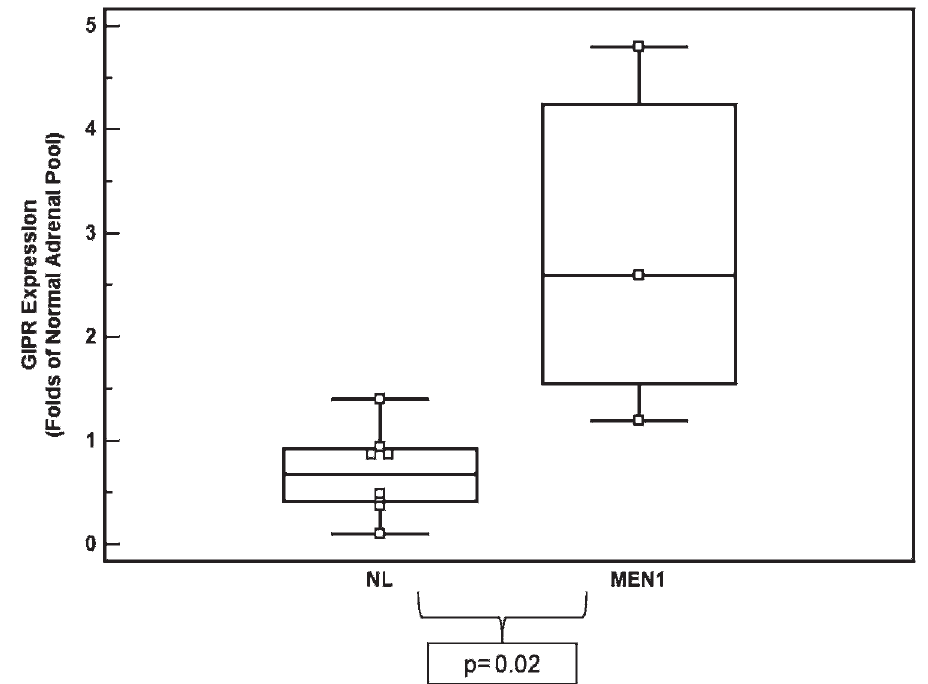
Figure 1 - GIPR expression in adrenal tissue from 3 patients with MEN1 syndrome as compared with normal human adrenal gland (median). GIPR expression in all analyzed tissues was 2.6-fold higher than that observed in normal adrenal